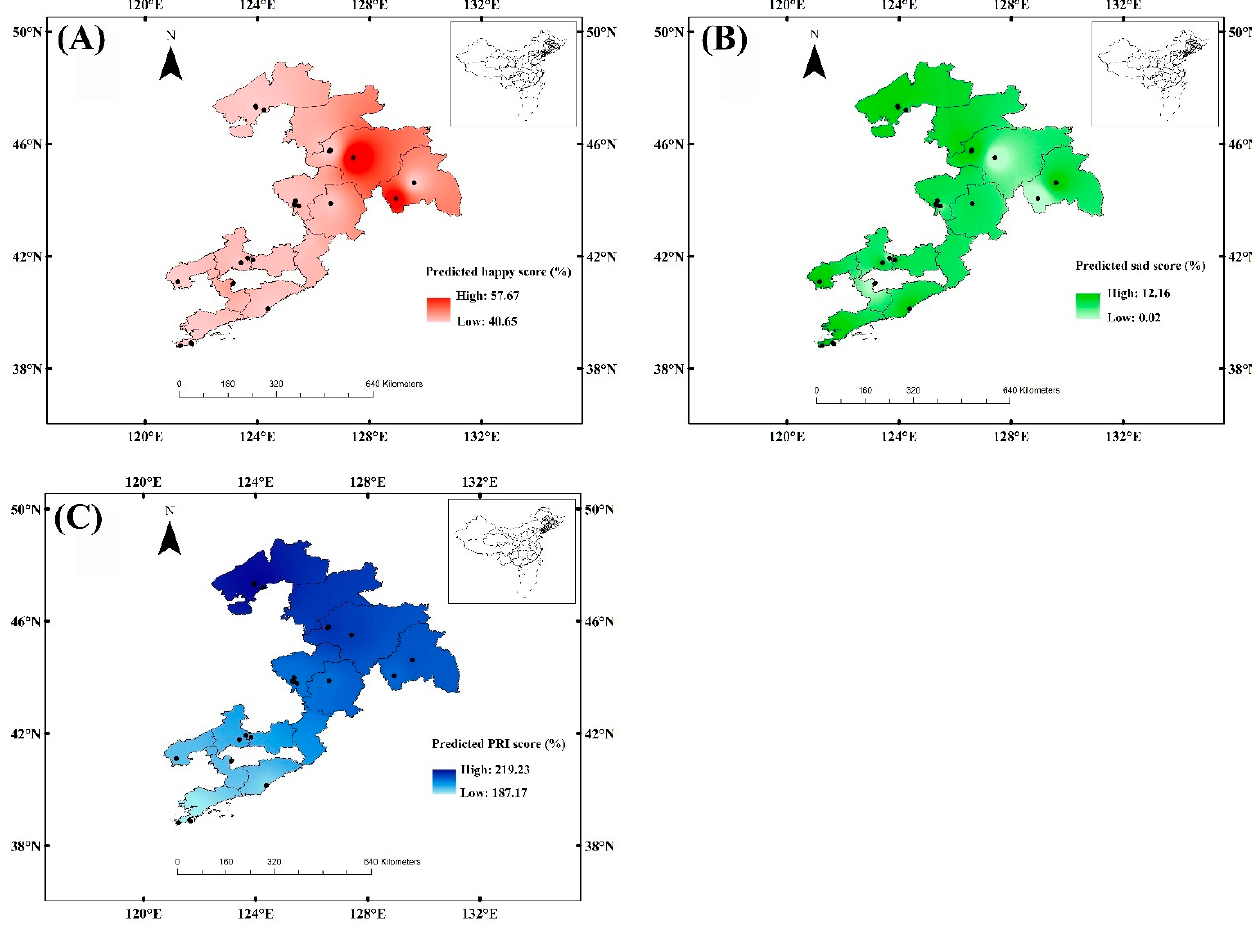
Figure 5. Spatial distribution of regressed facial expression scores by multivariate linear models (Table 5) against inde- pendent variables green land area and aquatic area in urban forest parks at cities of Northeast China. Solid spots present locations of parks. Data for mapping geographical patterns were predicted by spatial interpolations. PRI, positive response index evaluating net positive emotions. ( A ) Predicted happy score, ( B ) Predicted sad score, ( C ) Predicted PRI